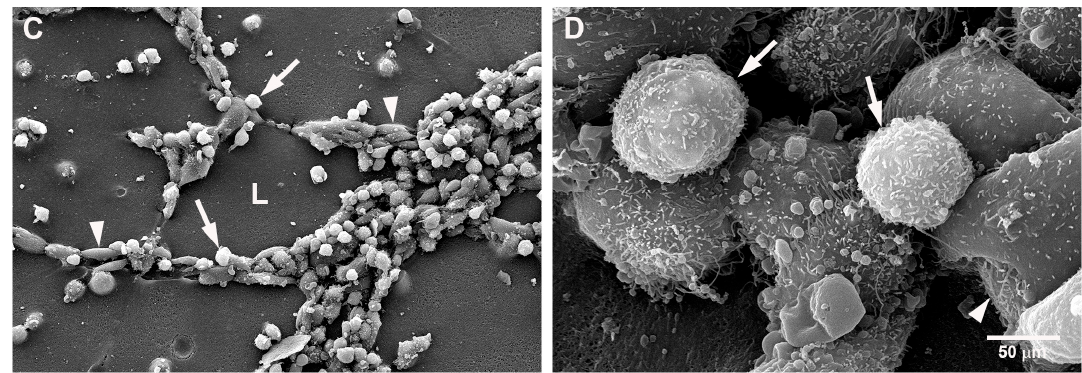
Figure 4. Mast cells and endothelial cells associate during the tube formation assay. ( A , B ) SVEC4-10 cells; ( C,D ) SVEC4-10 cells co-cultured with P815 mast cells. ( A , B ) In cell cultures without mast cells, the endothelial cells form only incomplete loops (arrowheads); ( C , D ) During co-culture SVEC4-10 endothelial cells (arrowheads) and mast cells (arrows) are associated especially in the loops (L). The endothelial cells are spread on the substrate (arrowheads) while P815 mast cells remain rounded (arrows). Cells were cultured for 5 h prior to assay. Scanning electron microscopy images are representative of four independent experiments.